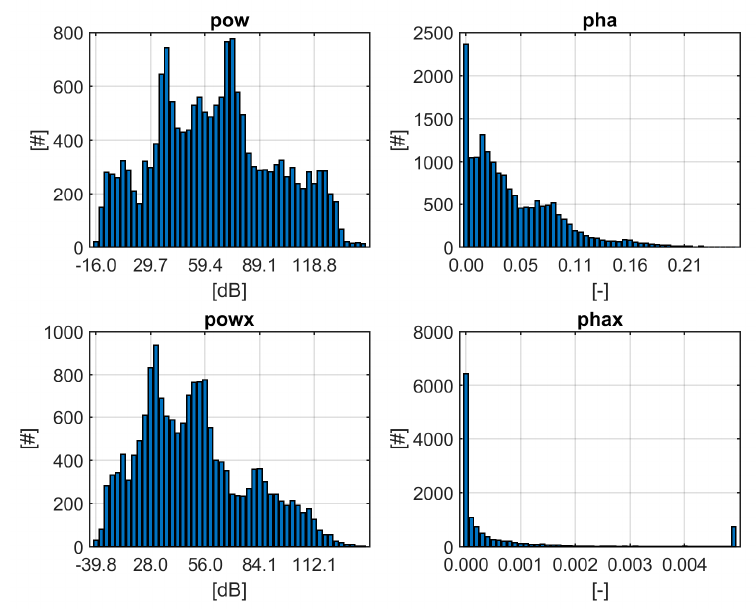
Figure 5. Distribution of measured pow, pha, powx and phax for near(1 km). The x-axis of phax (right lower panel) shows accumulated number of values larger than 0.005. Both pha and phax are expressed in arctan of the phase degree.